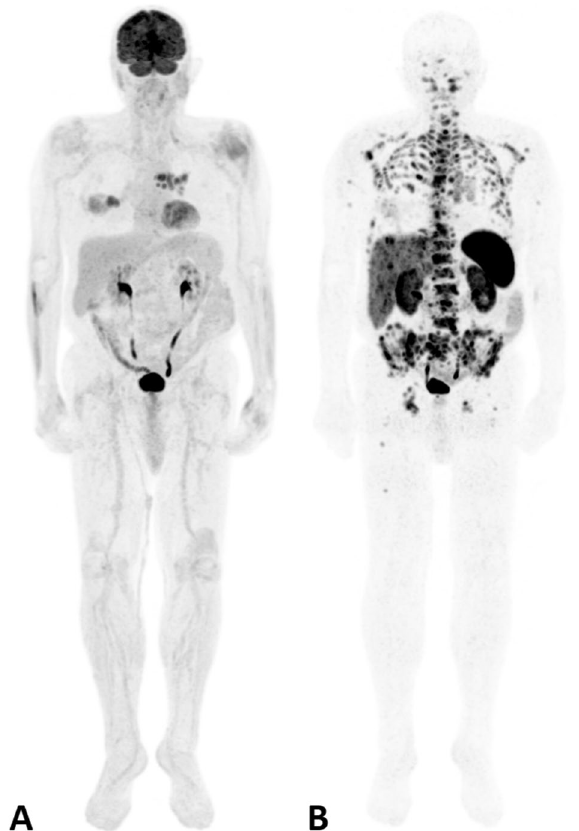
Fig. 1 Maximum Intensity Projection (MIP) images of [ 18 F]FDG PET/CT ( a ) and [ 68 Ga]Ga-DOTA-TOC PET/CT ( b